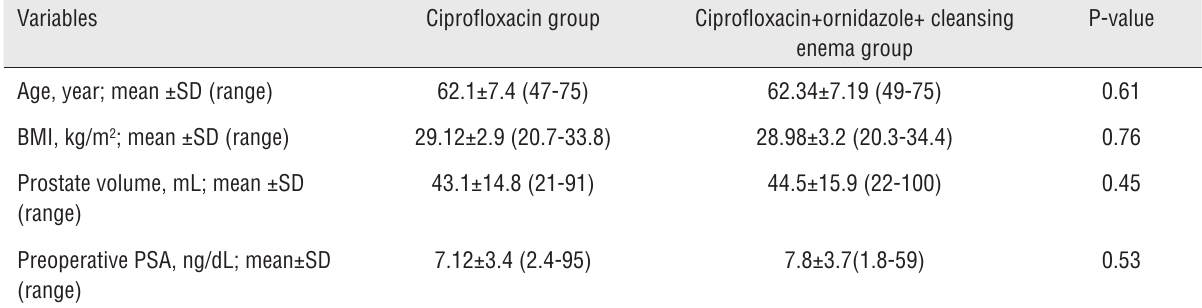
Table 1 - Descriptive